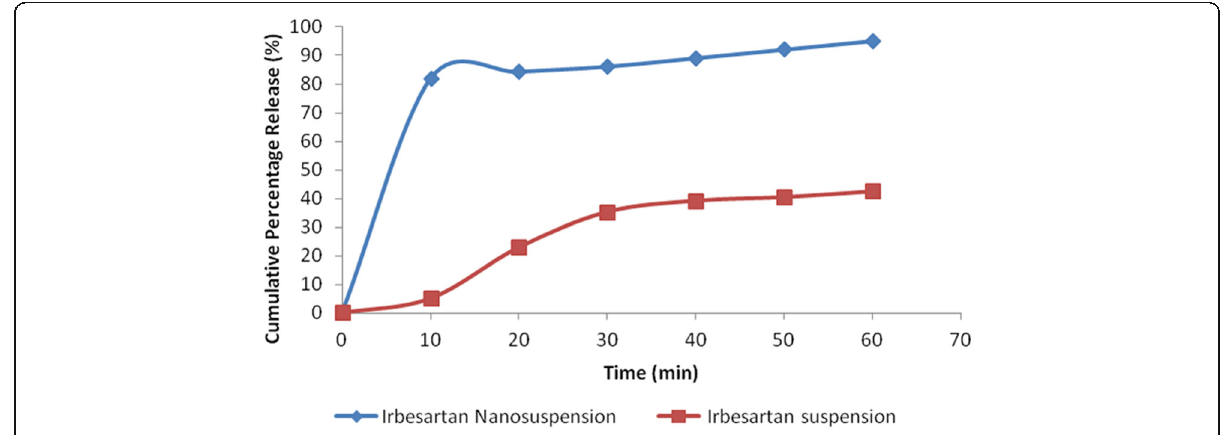
Fig. 8 Dissolution (in vitro) comparison of prepared nanosuspension and simple drug